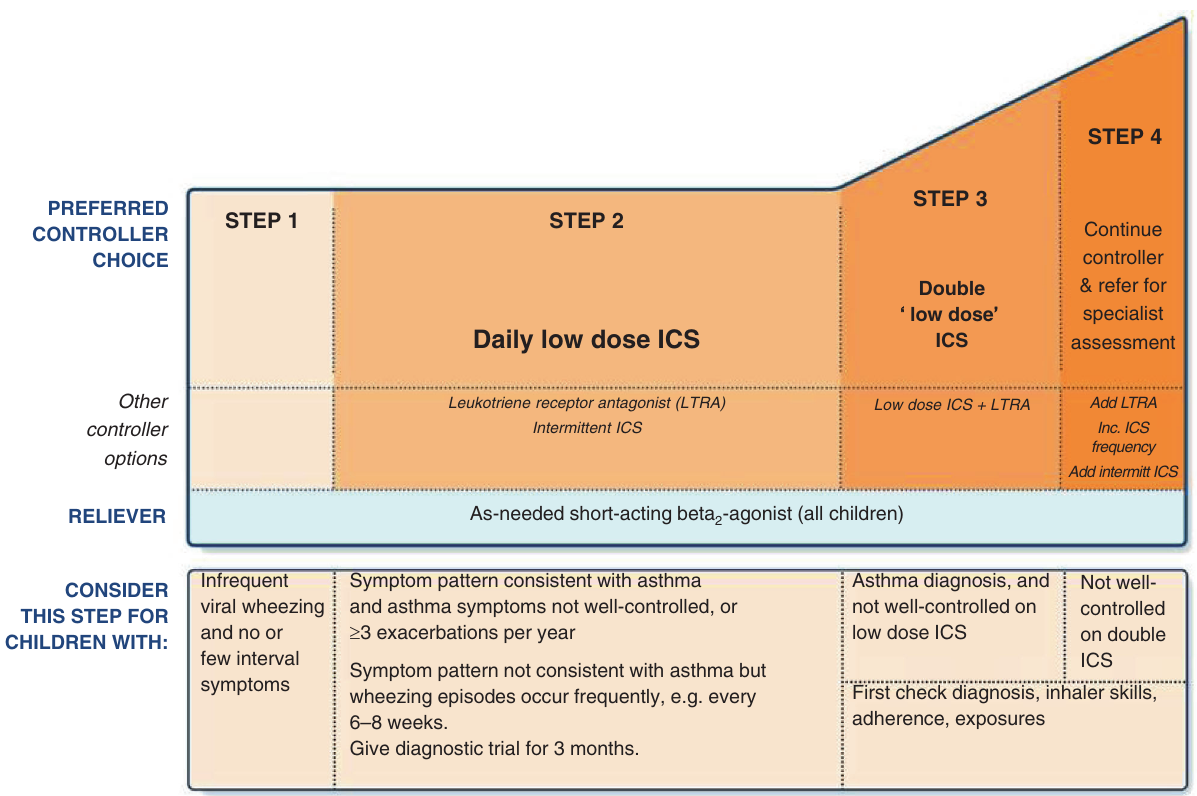
Fig. 1 Stepwise approach to pharmacotherapy in children under 5 years. Reproduced with permission from the GINA guidelines.